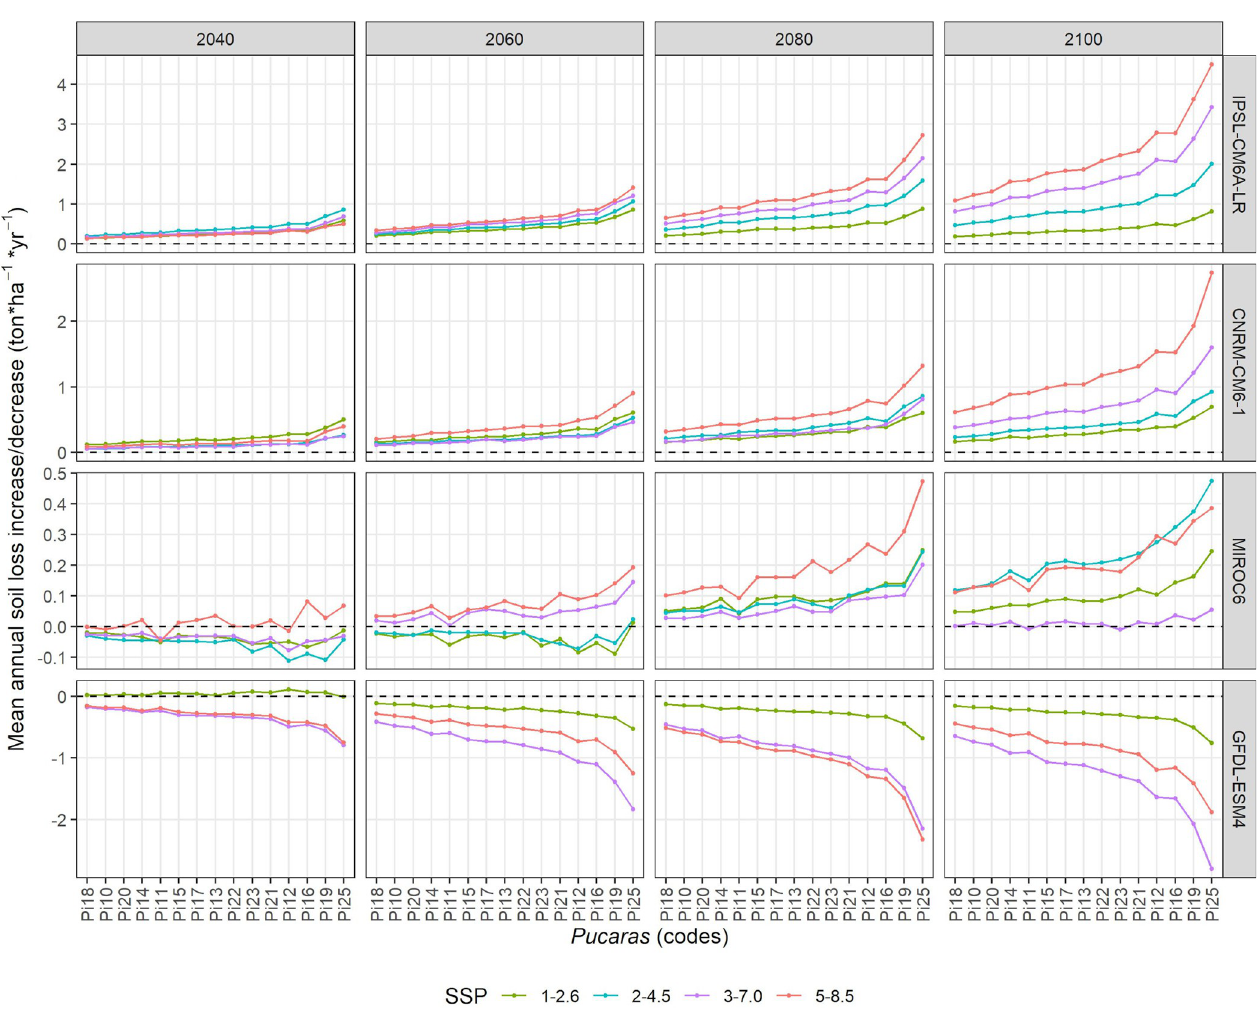
Fig 5. Mean annual soil loss increase/decrease between current and future conditions derived with the climate simulations from the different modeling centers (rows), SSPs (color lines), and time steps (columns) for the Pucaras analyzed in this research.